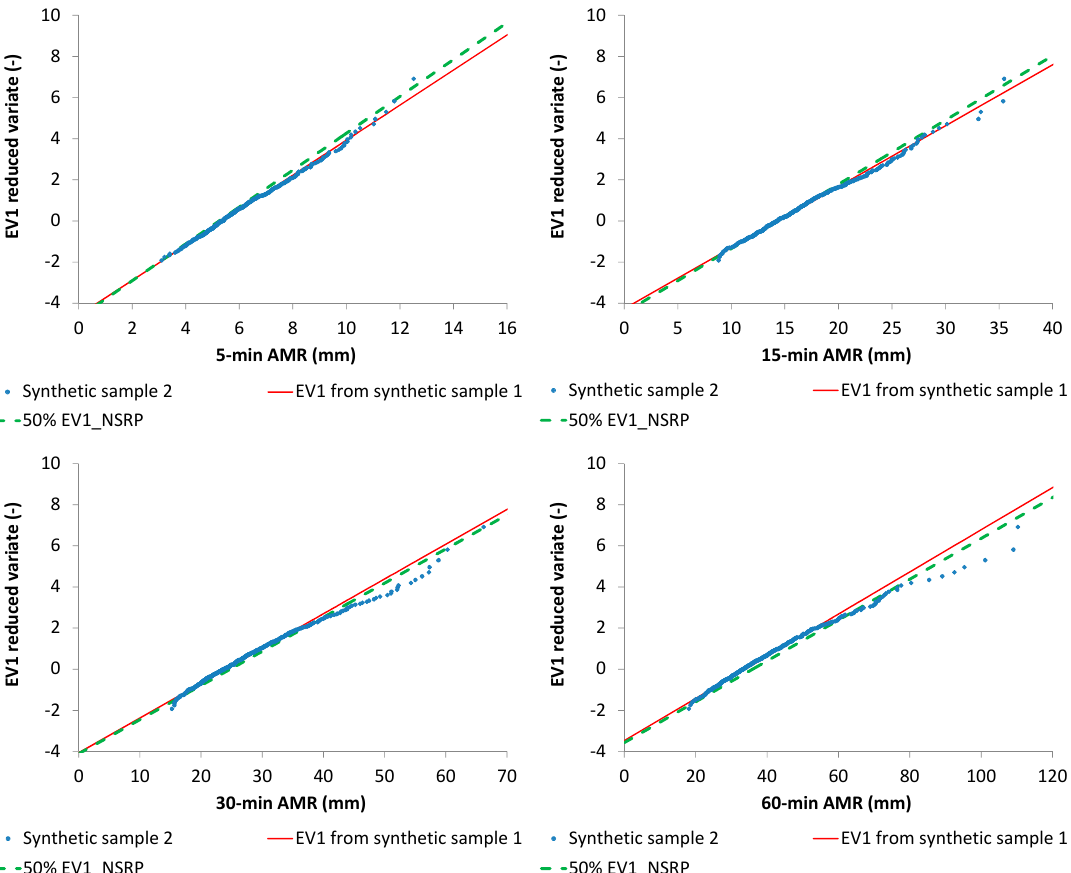
Figure 10. Synthetic sample 2: EV1 probabilistic plots with AMR series, their EV1 theoretical curves and median EV1 curves from NSRP generation.